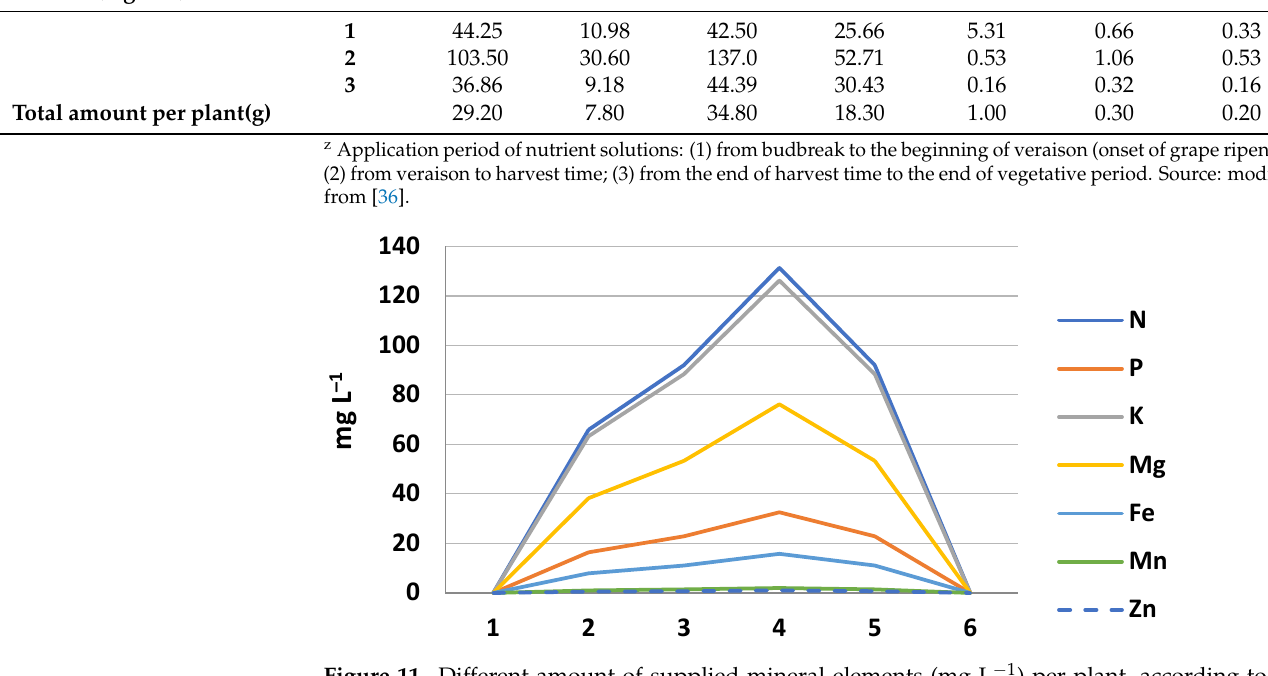
Table 11. Number and frequency of irrigations, and amount of water supplied per period and per plant (minimum and maximum values) z